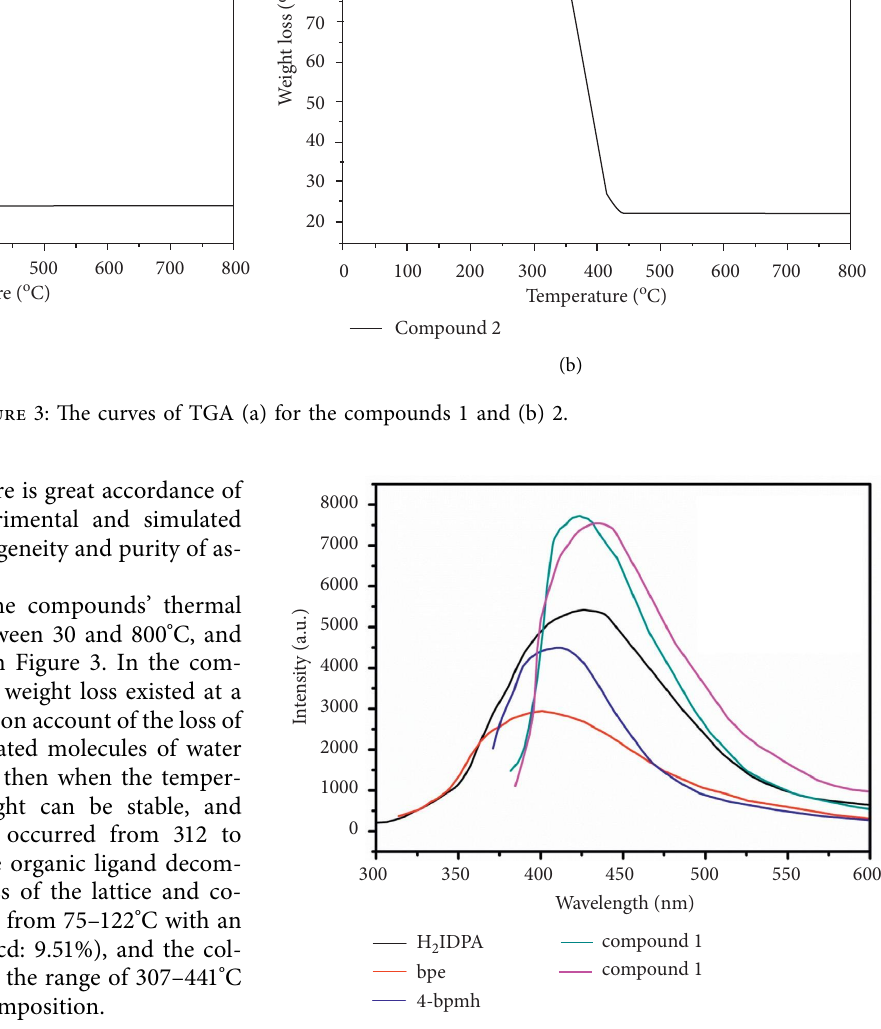
Figure 4: The luminescent emission spectra of the associated free organic ligand and the complexes at RT. Compound significantly reduces the viability of the HaCaT